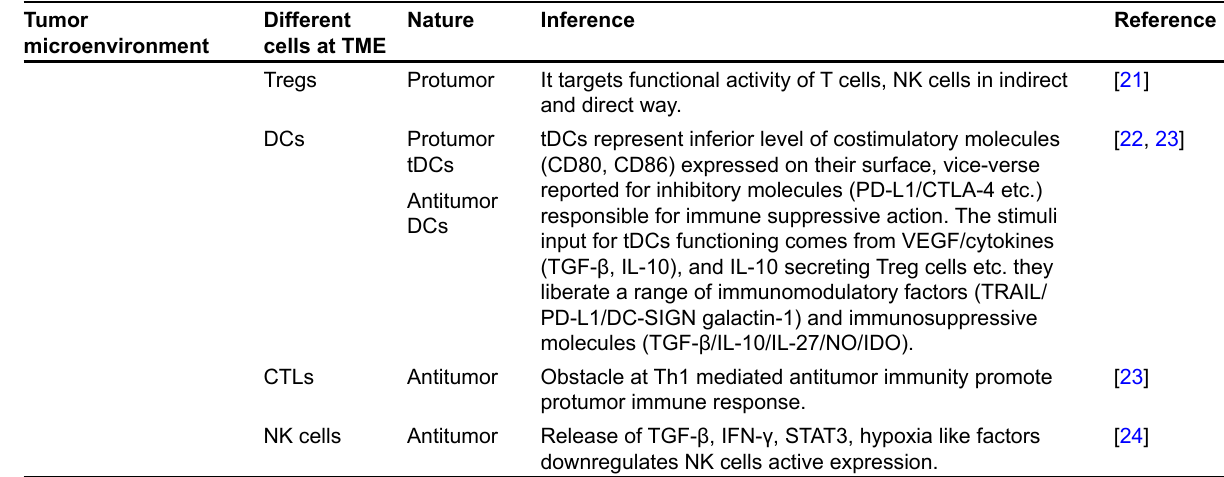
Table 1. Tabular representation of various oncogenic cells at TME ( continued ) Tumor microenvironment